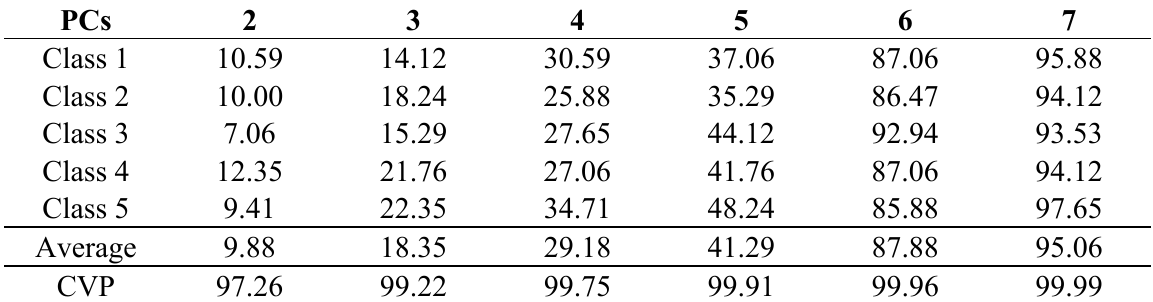
Table 2. The classification performance of the KIII model for five kinds of green tea with the increase of its parallel